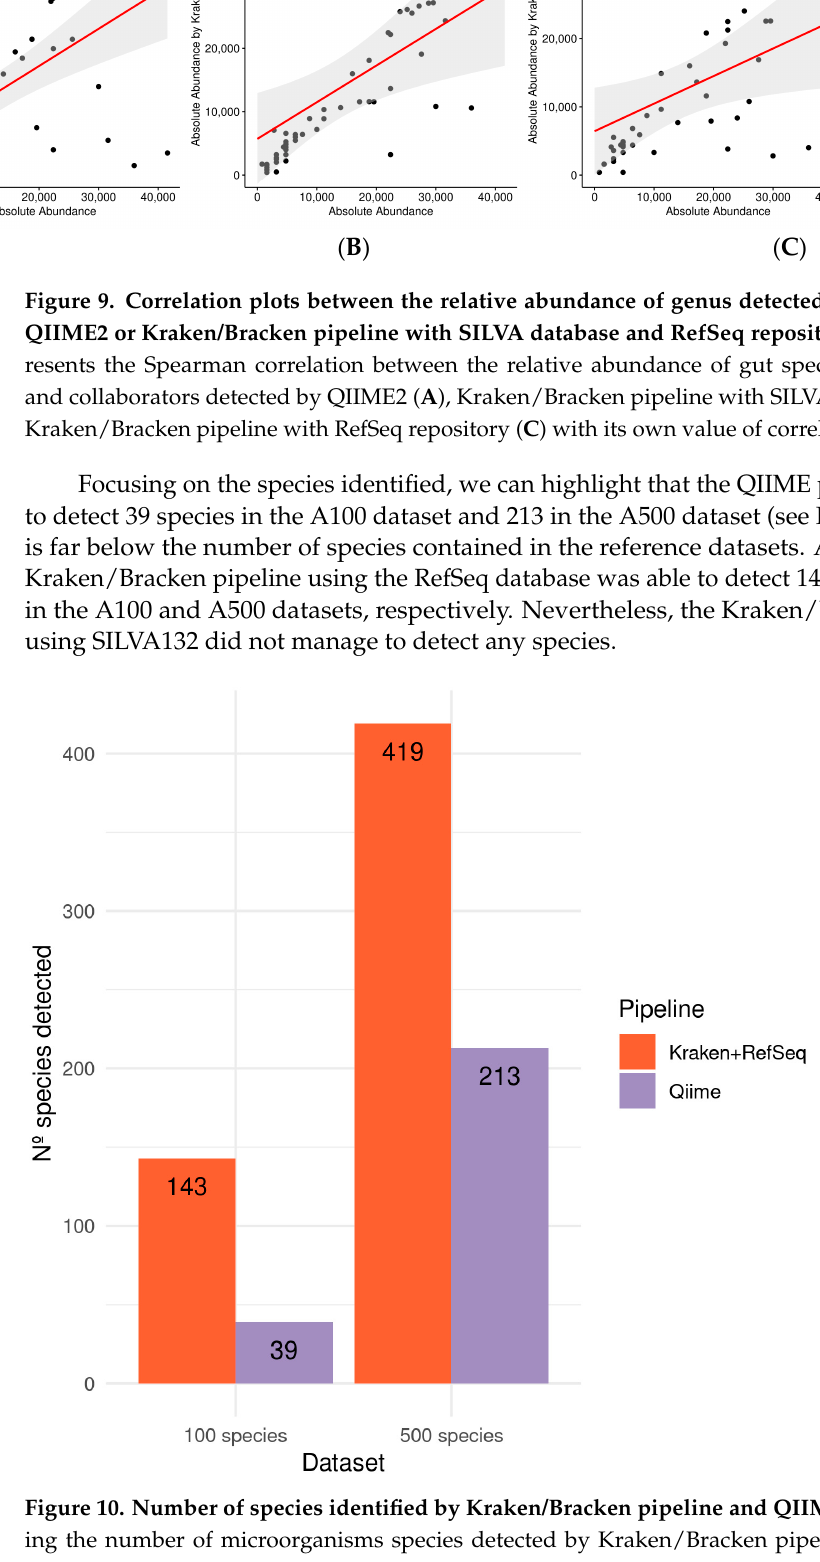
Figure 10. Number of species identified by Kraken/Bracken pipeline and QIIME2. Barplot show- ing the number of microorganisms species detected by Kraken/Bracken pipeline (using RefSeq da- tabase) and QIIME2 in gut data from Almeida and collaborators.